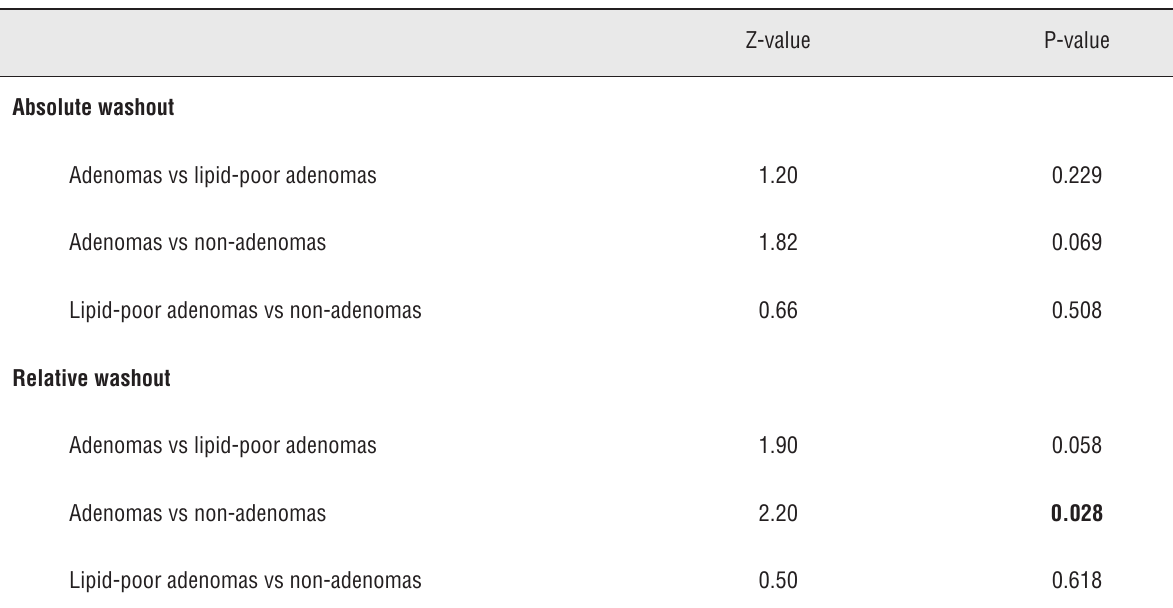
Table 4 - Comparisons of absolute and relative washouts among the three